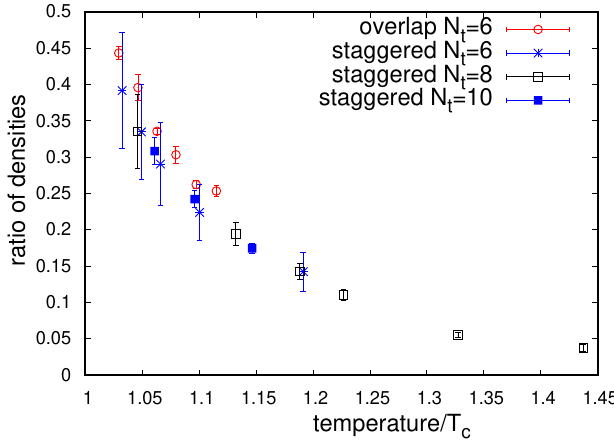
Figure 14. The fraction of localized modes in the quenched theory that are topology-related near-zero modes. The figure shows data calculated with the overlap Dirac operator on N t = 6 lattices, as well as with the staggered Dirac operator using three different lattice spacings corresponding to N t = 6,8 and 10. From Ref. [86]. (Figure adapted from T.G. Kovács and R.Á. Vig, PoS LATTICE2018, 258 (2019), and used under a CC-BY-NC-ND 4.0 license